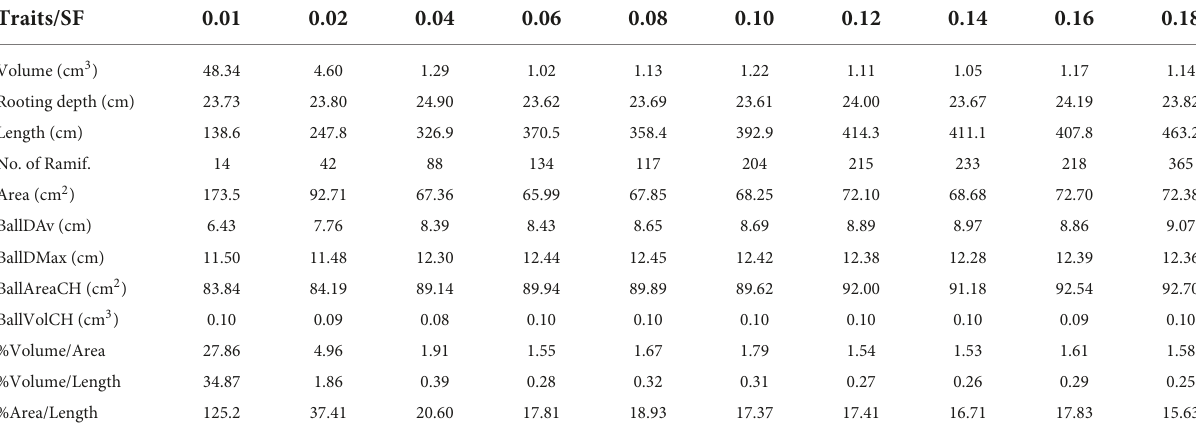
TABLE 1 Total traits computed using different scale factors: volume, depth, length, area, number of ramifications, mean and maximum root ball diameter, convex-hull root ball area and volume, and 3 fractions between volume, area, and length.